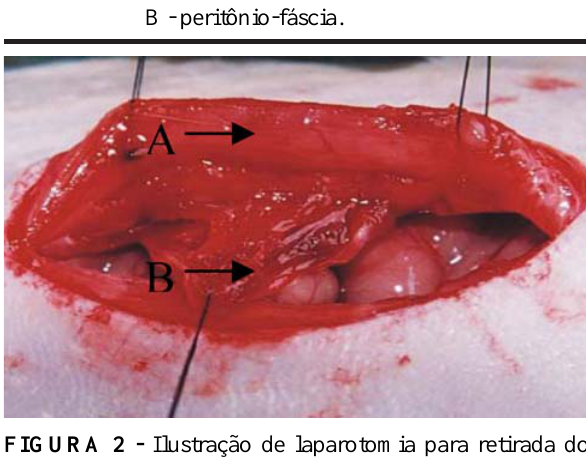
FIGURA 2 - Ilustração de laparotomia para retirada do espécime. A - parte do músculo reto do abdome e B